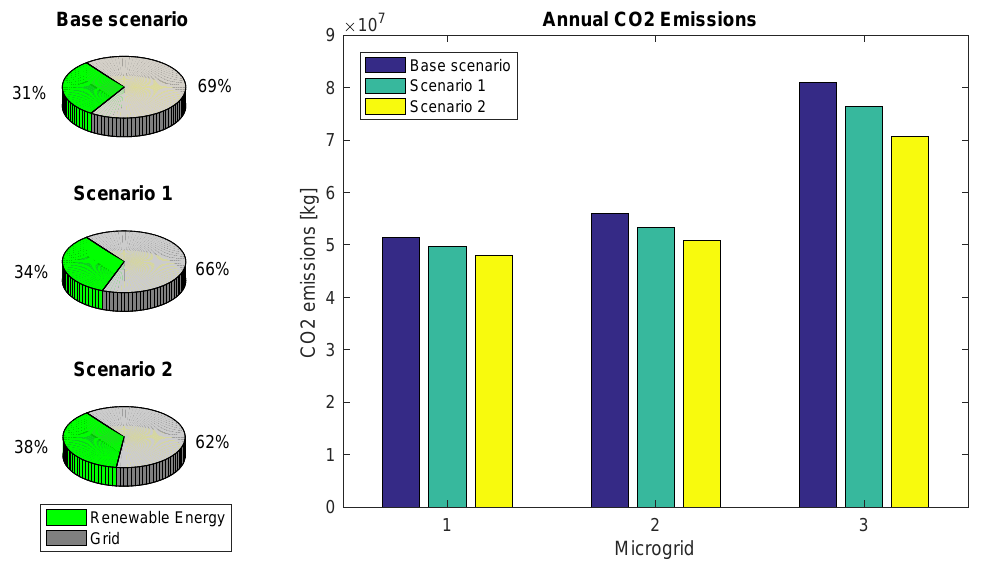
Figure 10. Annual renewable energy fraction and CO 2 emissions for each